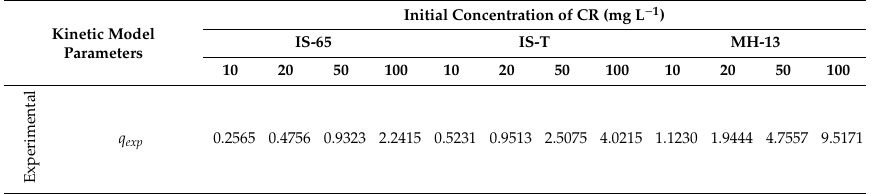
Table 5. The values of intraparticle di ff usion coe ffi cients.